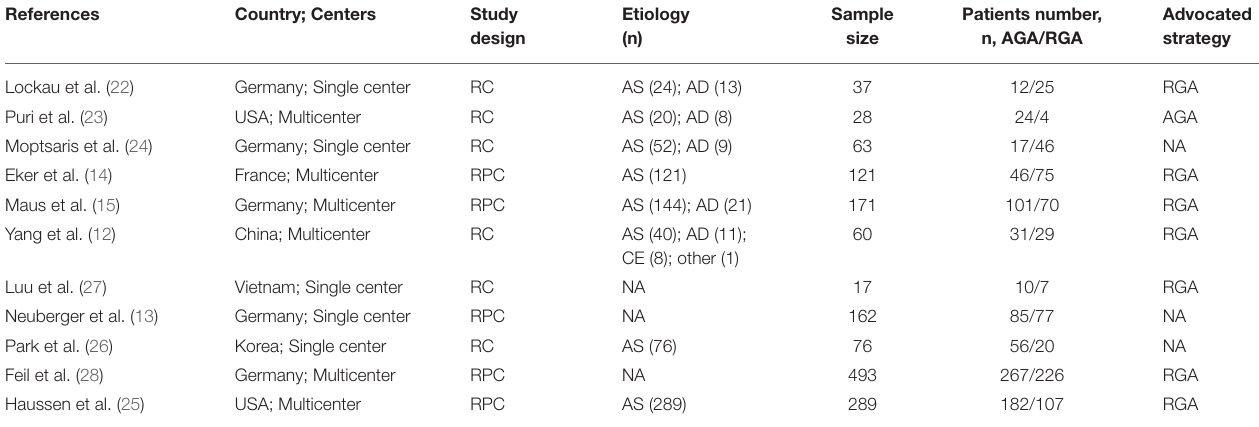
TABLE 1 | Characteristics of included